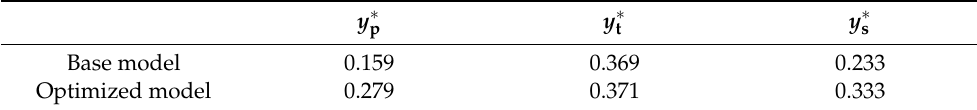
Table 5. Comparison of structural parameters before and after optimization.